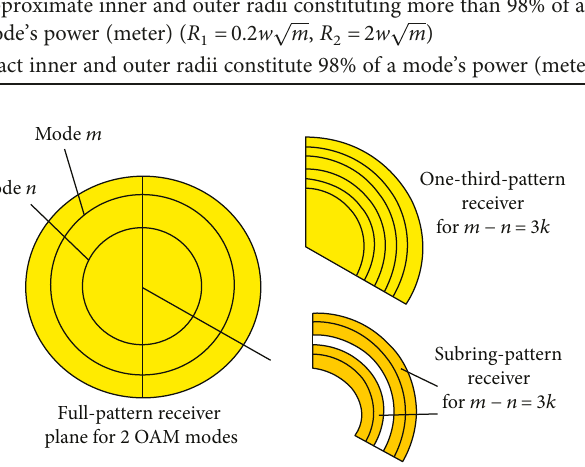
Figure 2: One-third subring matching